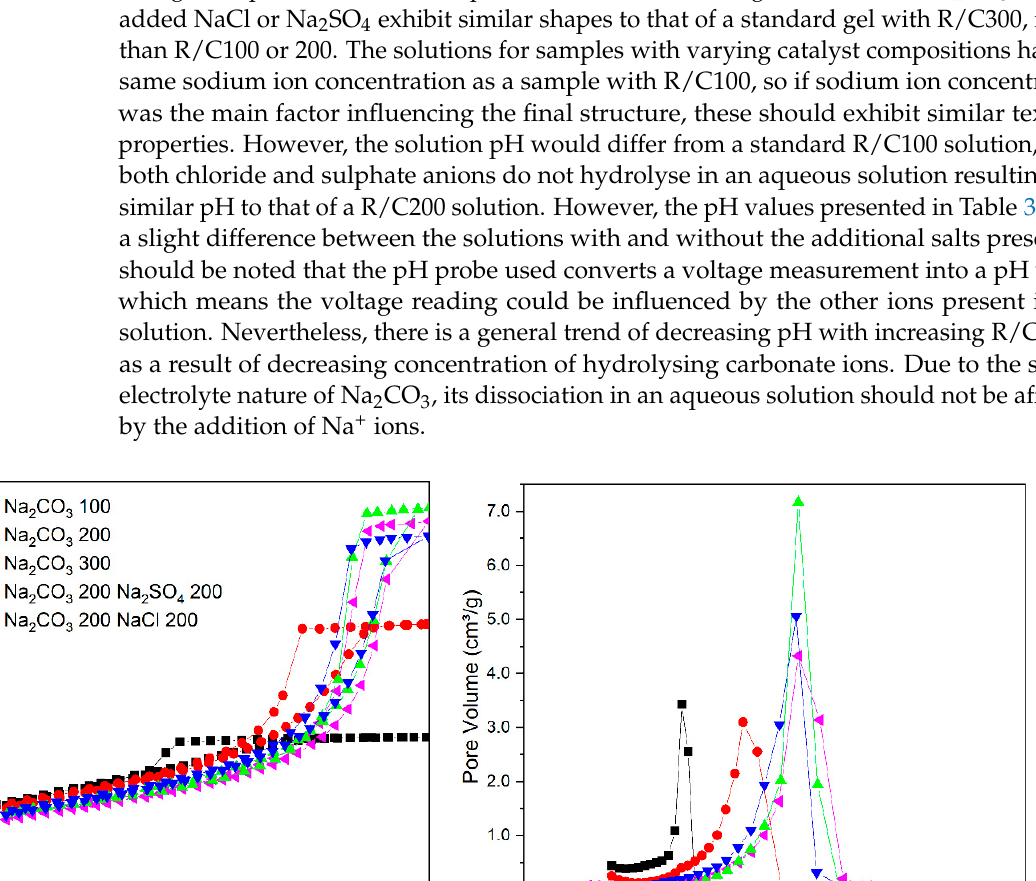
Figure 8. Nitrogen sorption isotherms of gels with modified catalyst composition ( a ) and corresponding pore size distri- butions ( b ).